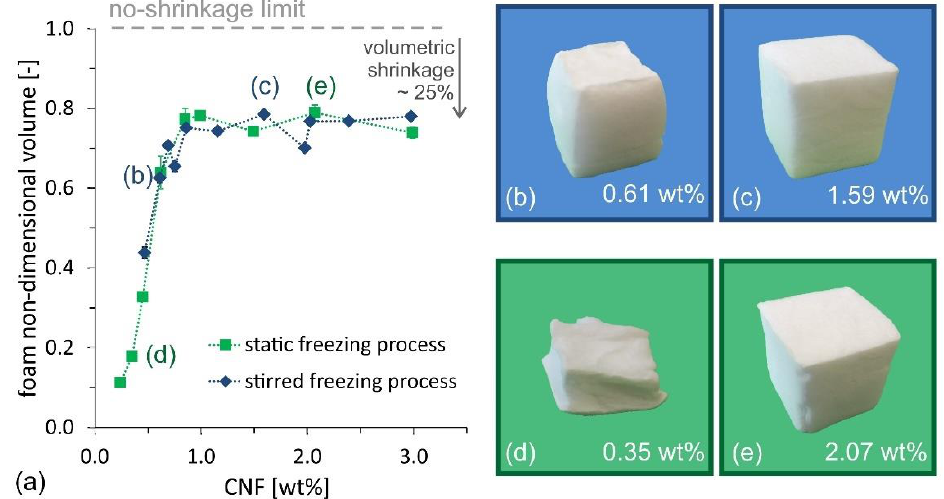
Figure 6. ( a ) Foam non-dimensional volume, calculated as the ratio between the final volume of the foam and the initial suspension volume, as function of suspension concentration, for CNF foams produced using the stirred freezing process (blue diamonds) and the static freezing process (green squares). Lines connecting experimental data are provided to guide the eye. Pictures illustrate representative samples produced using the stirred freezing process ( b , c ), with CNF concentration equal to 0.61 wt% and 1.59 wt%, respectively) and the static freezing process ( d , e ), with a CNF concentration equal to 0.35 wt% and 2.07 wt%, respectively).